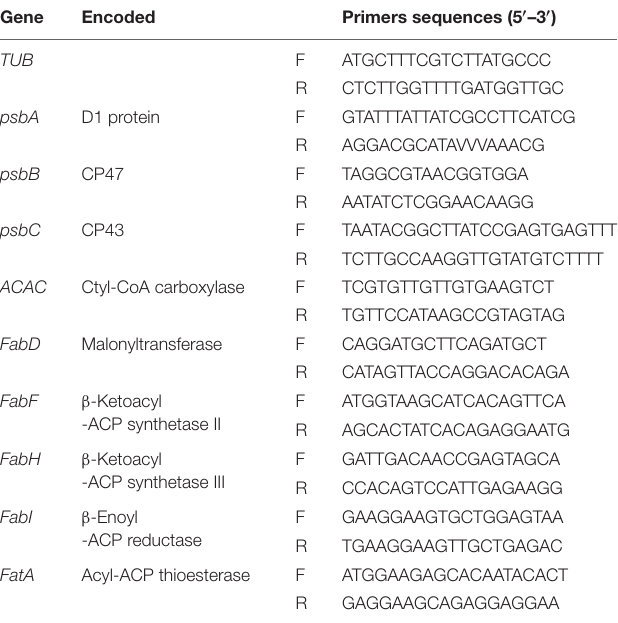
TABLE 1 | Primer sequences used for Q-PCR